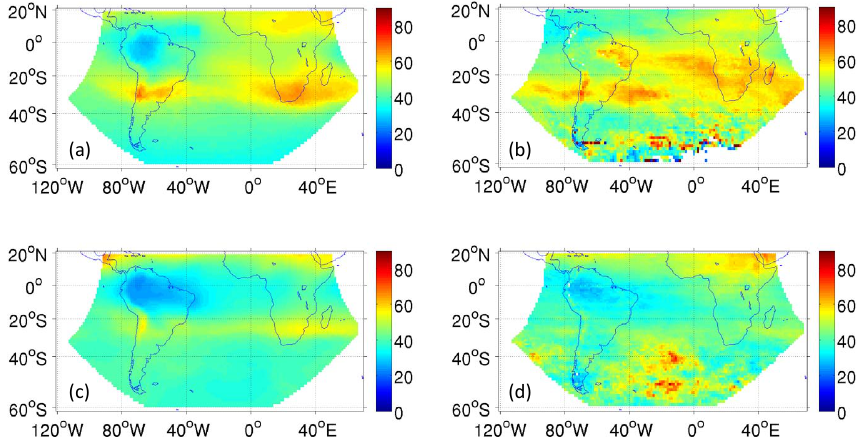
Fig. 5. Mean tropospheric O 3 (ppbv) for November 2008 (a, b) and May 2009 (c, d) from the model (a, c) and from OMI/MLS (b, d) .